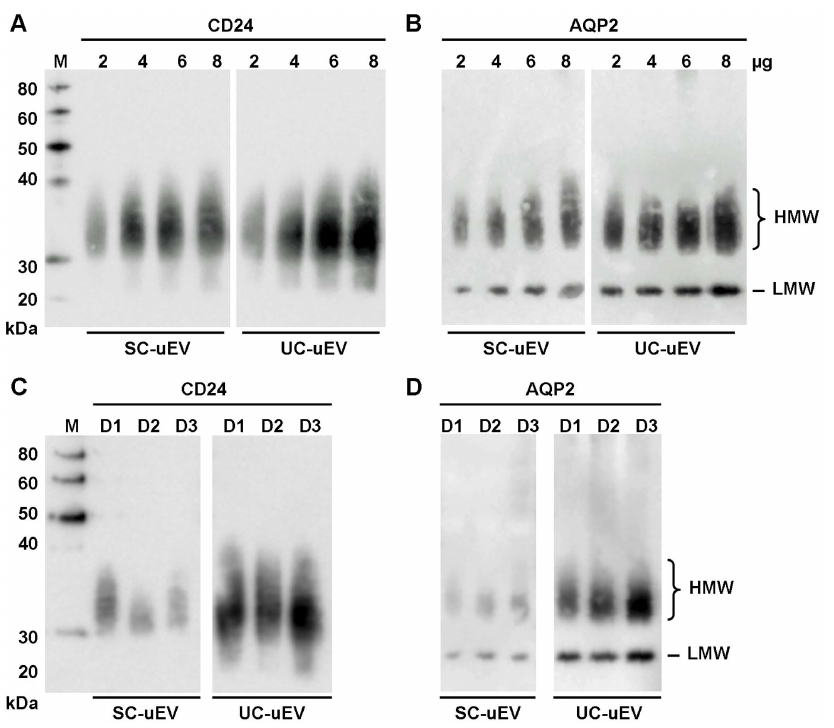
Figure 2. Immunoblots of SDS-PAGE-separated UC- and SC-uEV proteins. Stepwise responses of 2 to 8 m g uEV protein with antibodies specific for ( A ) CD24 and ( B ) AQP2. Inter-individual variability of ( C ) CD24 and ( D ) AQP2 content for equal amounts of SC- and UV-uEV proteins from three individuals (lanes D1, D2 and D3). 5 m g/well loaded for (C) CD24 detection, 4 m g/well loaded for (D) AQP2 detection. Lane M represents M r standard. Data is representative of a minimum of 10 individual uEV enrichment experiments for each method.